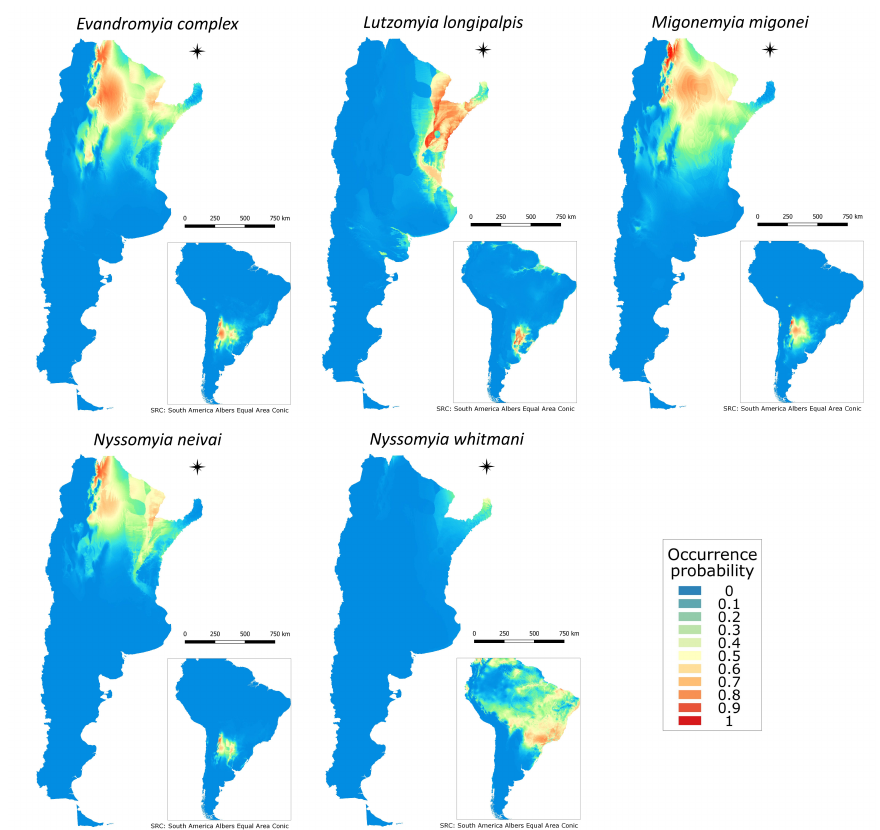
Figure 2. Occurrence probability maps for the five most important sandfly species in Argentina. At the bottom-right of each map is the result of the distribution model for South